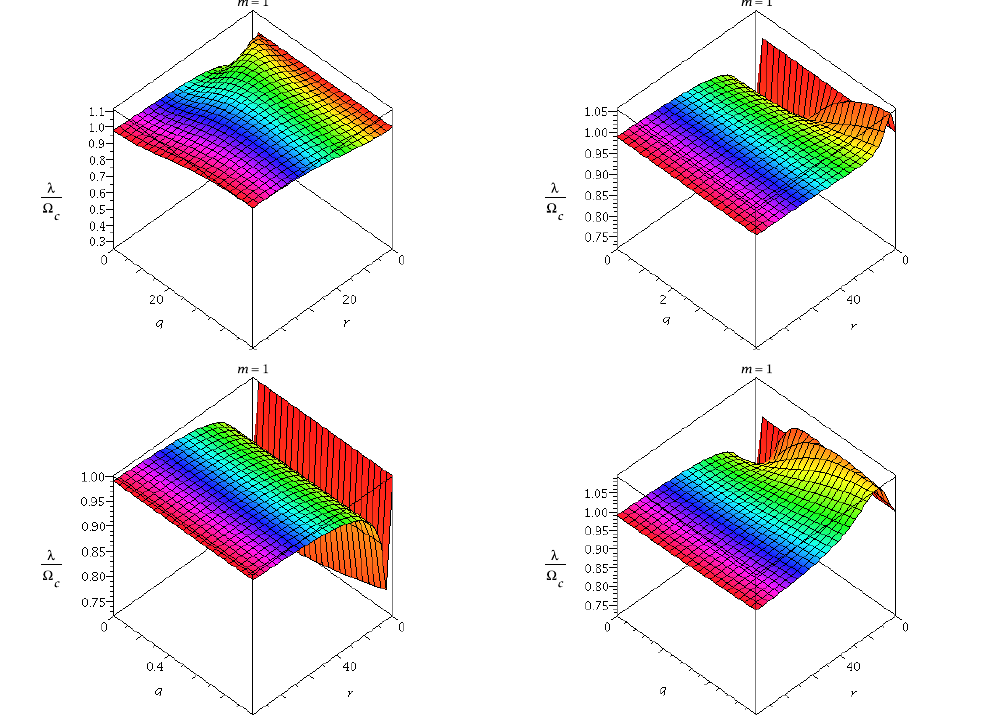
with r c and q for ABG BH. c